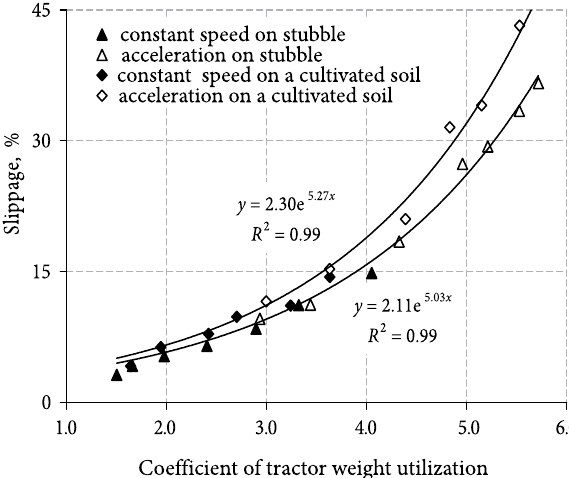
Fig. 7. The dependence of wheel slippage on the coefficient of weight